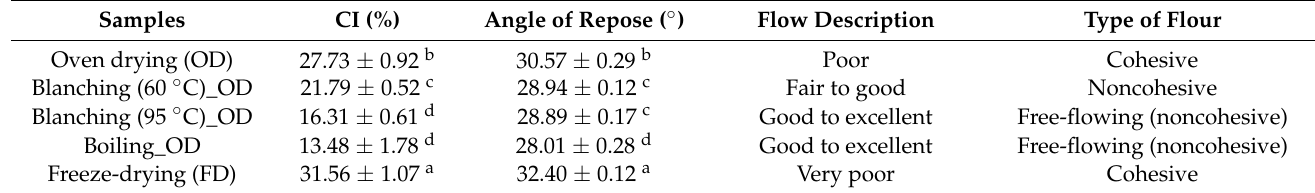
Table 4. Compressibility Index (CI) and angle of repose of potato